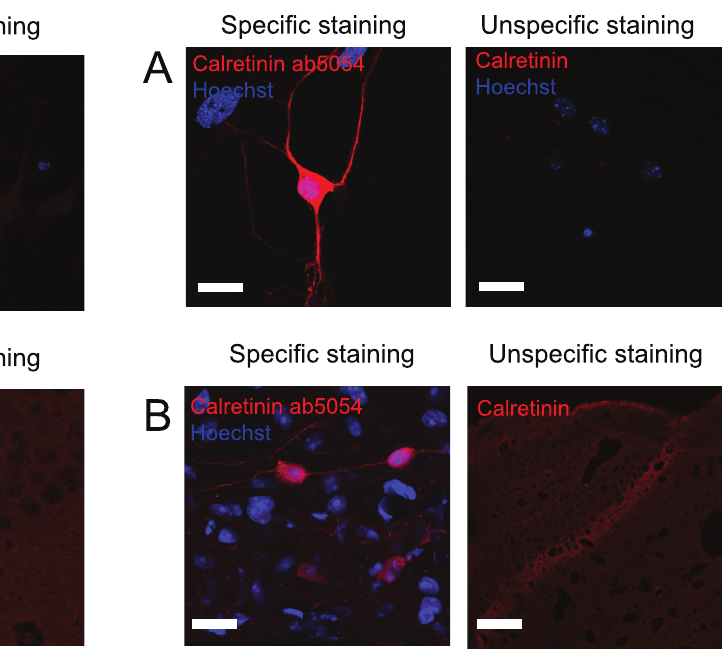
Figure 1. Staining against parvalbumin interneurons. Figure 1 shows immunostaining against parvalbumin on A ) cultured hippocampal neurons and B ) hippocampal tissue. Left pictures shows an example of an immunostaining considered to be specific while right picture shows an example where immunostaining using other primary antibodies did not meet the criteria and therefore was considered unspecific. Scale bar represents 20 μm.